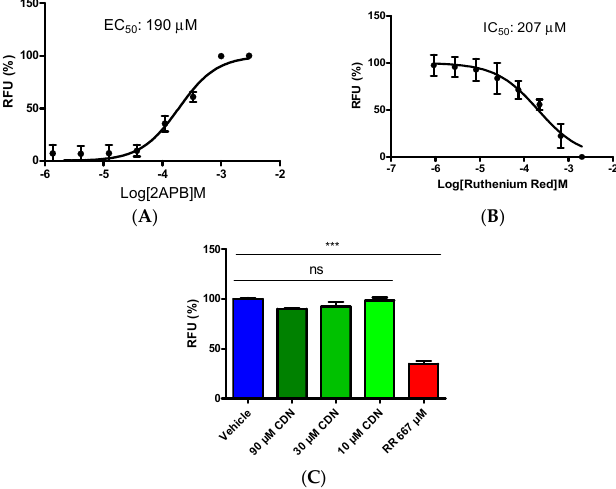
Figure 3. The effect of cardamonin on inhibiting TRPV1 activation. ( A ) Concentration-dependent activation of TRPV1 channel by 2APB; ( B ) inhibitory concentration-response curve for ruthenium red. The intracellular Ca 2+ flux was assayed using FlexStation II plate reader the moment of adding 1 mM 2APB; and ( C ) statistical analysis of effects of cardamonin on TRPV1 activation. HEK293/TRPV1 cells were pre-treated with cardamonin for 10 min and then challenged with 1 mM 2APB at 37 °C. Data represent mean ± SEM, n = 3; ns, no significant differences, *** p < 0.001, by one-way ANOVA analysis.